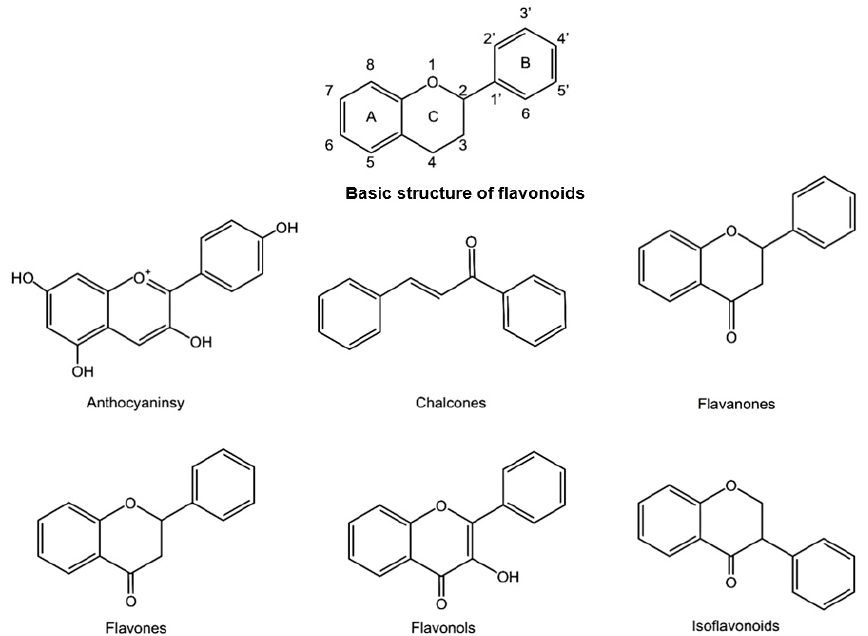
Figure 1. The basic structure of flavonoids and their six main subgroups. This figure was created using